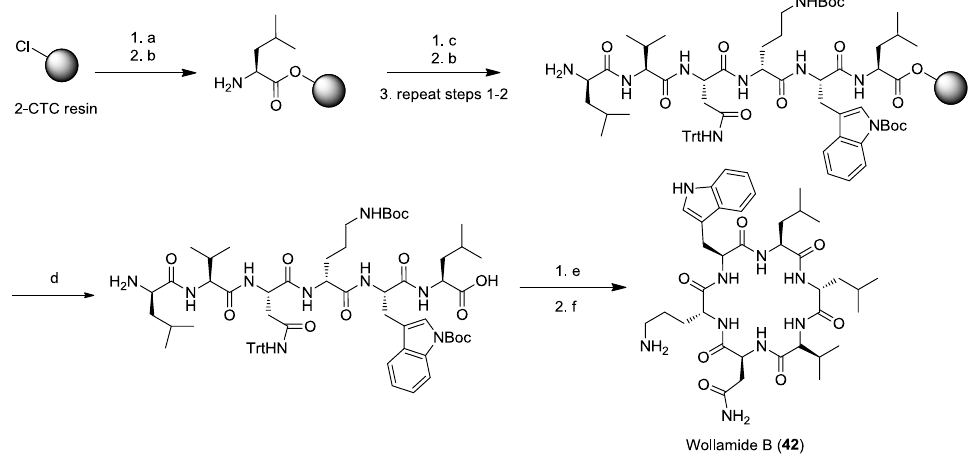
Figure 8. Structures of cyclohexapeptides 43 – 47 .